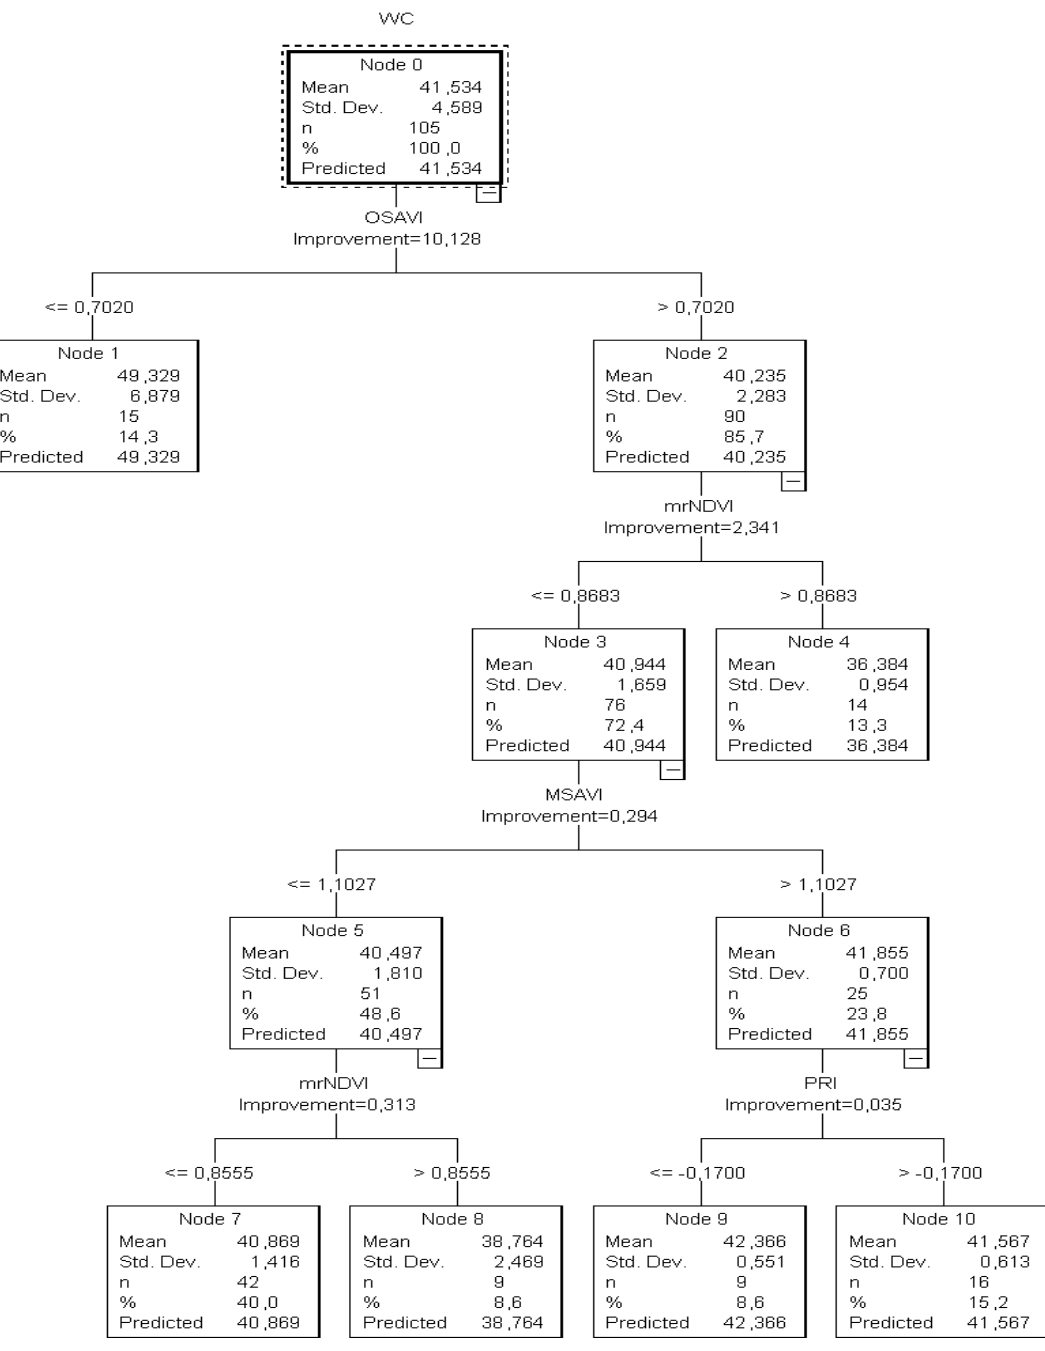
Figure 4. The CT3 classification tree of the training sample for calibration to predict the plant θ values in the root zone (%).